Question: Which visualization type does this figure use?
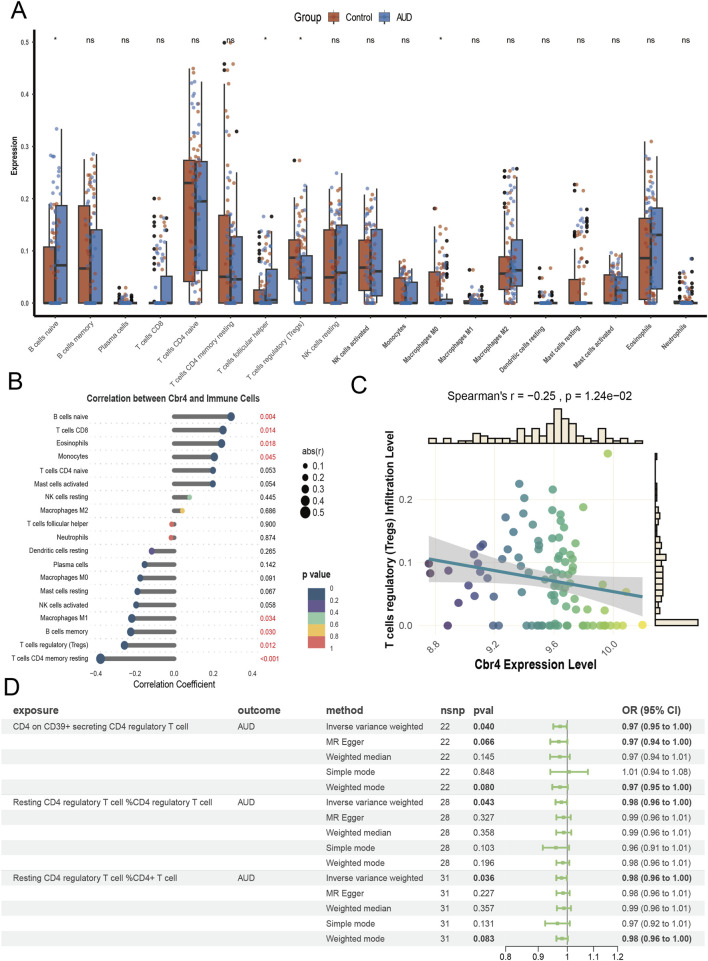
Answer: scatter